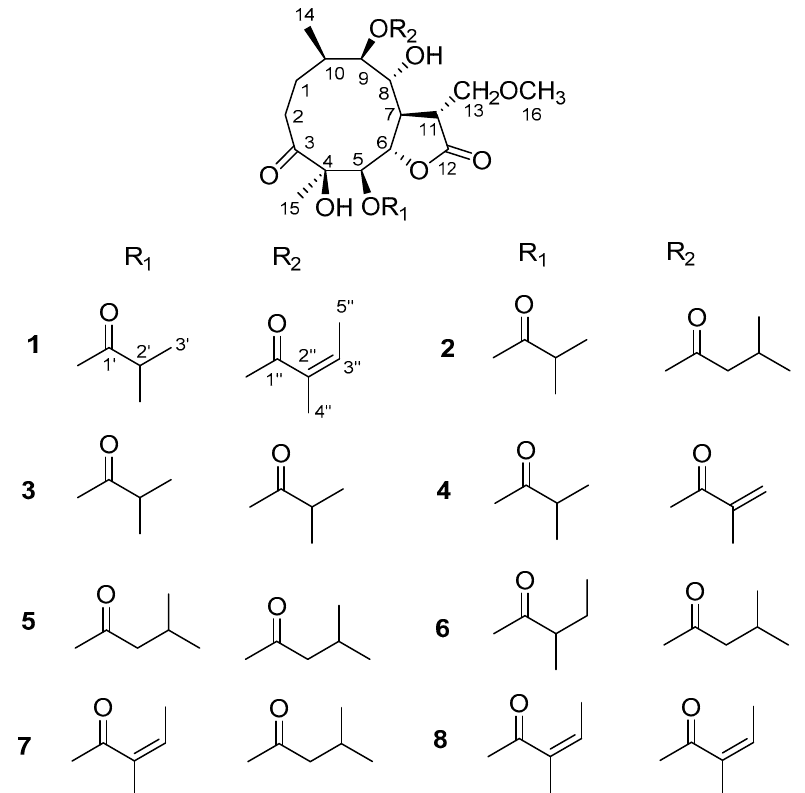
Figure 2. Structures of compounds 1 – 8 .